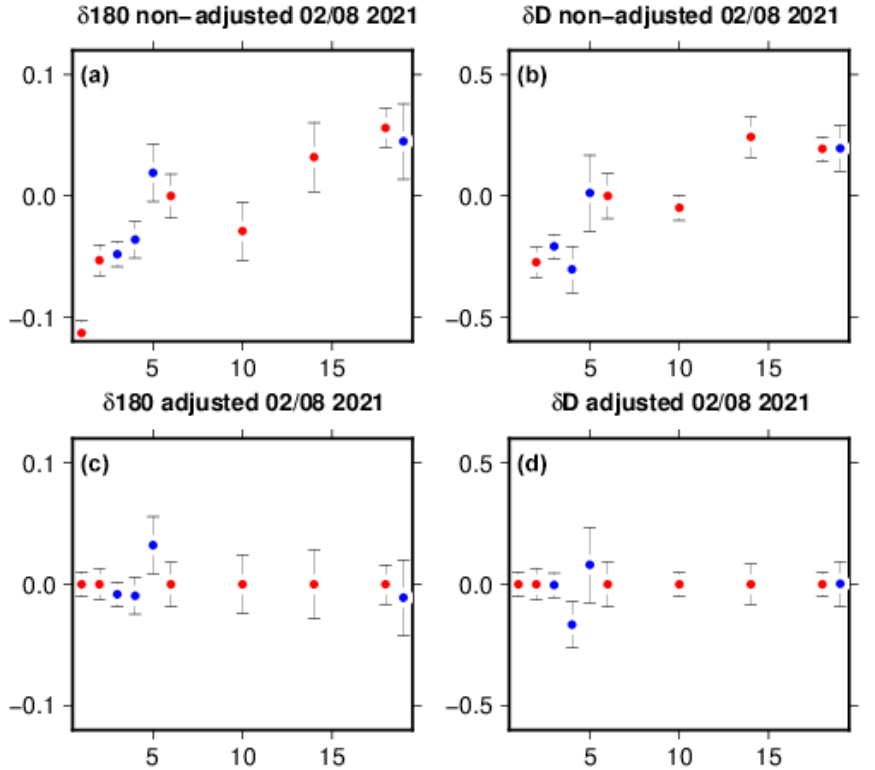
Figure 1. A typical run (on 2 August 2021) of 19 samples using three internal standards and Kona Deep water samples (left for δ 18 O and right for δ D). Top panels (a, b) : the deviations of isotopic values (‰) of internal standards (in blue) and of the Kona Deep water samples (in red) relative to their expected values (horizontal axis is sample number). Error bars are the standard deviation of the different injections, and the vertical scale is arbitrarily set so that 0 corresponds to Kona Deep sample 6 (after the three internal standards). The lower panels (c, d) present the values obtained after adjusting for the drifts identified with the Kona Deep water samples through the